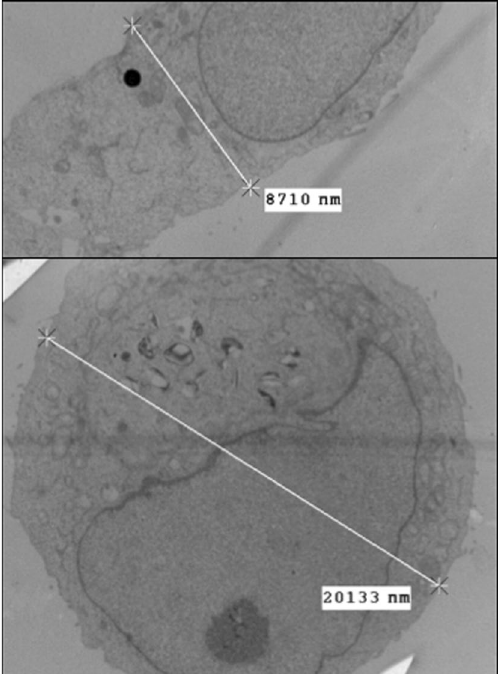
Figure 1. Morphometric analysis of electron micrographs taken of ultra-thin sections of Hec50co endometrial cells. Volumes for each simulation cellular compartment (cytoplasm, nucleus) were determined from estimations of suspended Hec50co